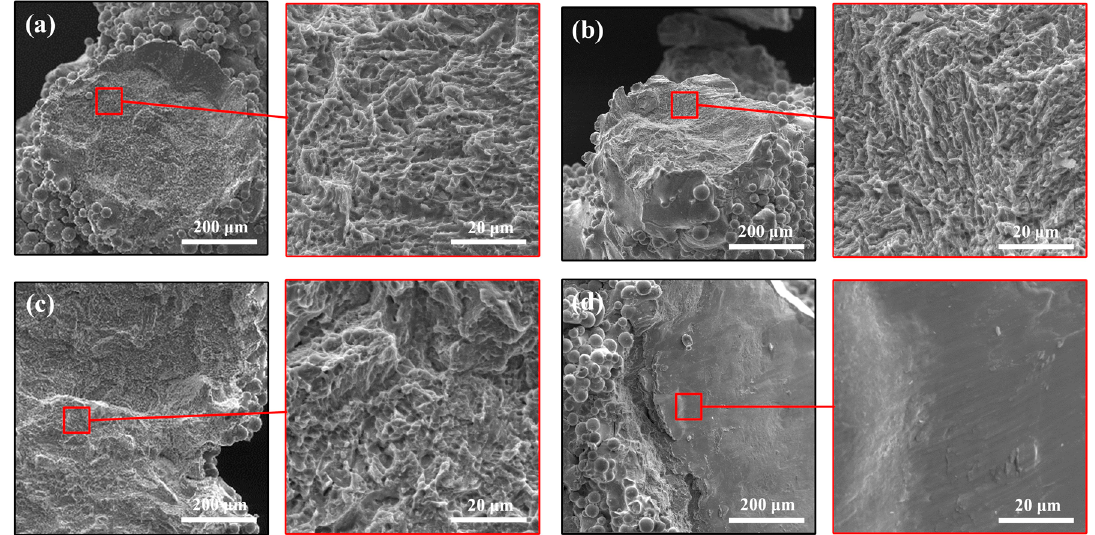
Figure 8. SEM micrographs of fracture surface of ( a ) B10, ( b ) BT10, ( c ) B30, and ( d ) BT30 after compression tests.